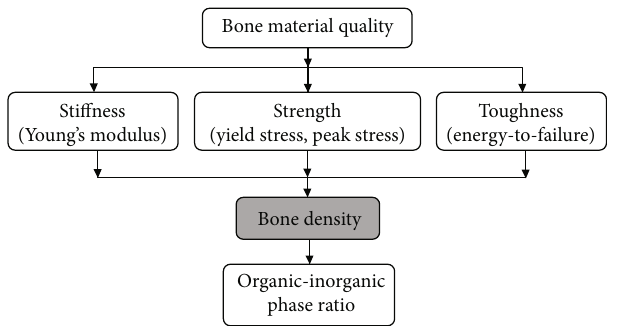
Figure 4: The dependence of bone material quality on organic- inorganic phase